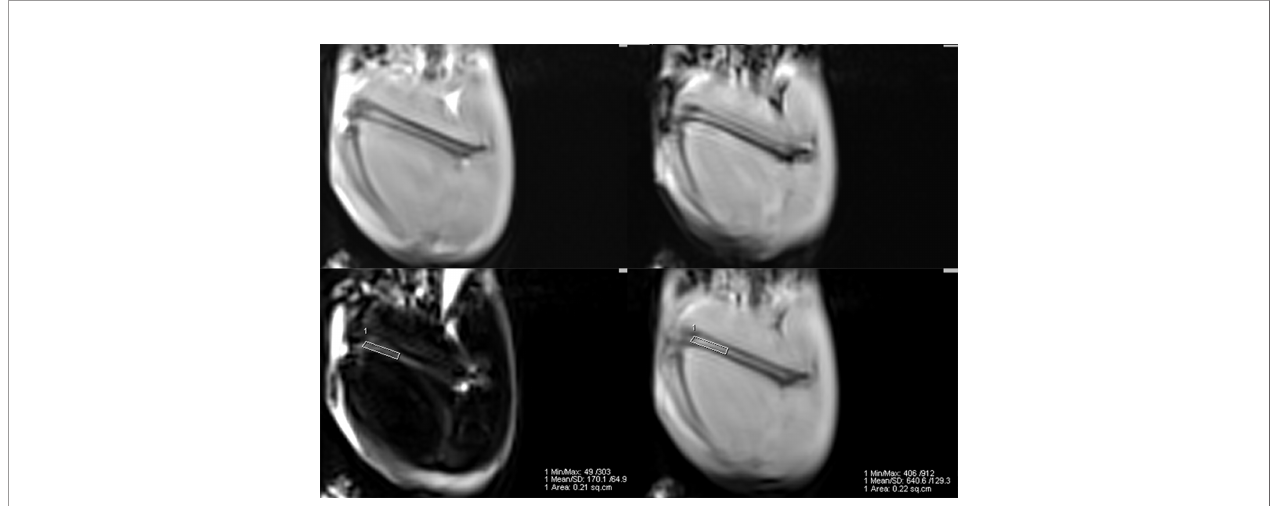
FIGURE 1 | Example of a 2-point Dixon sequence for measuring fat fraction. The region of interest was manually drawn in the distal femur in a fat-only image, avoiding the cortical bone, and directly copied onto a water-only